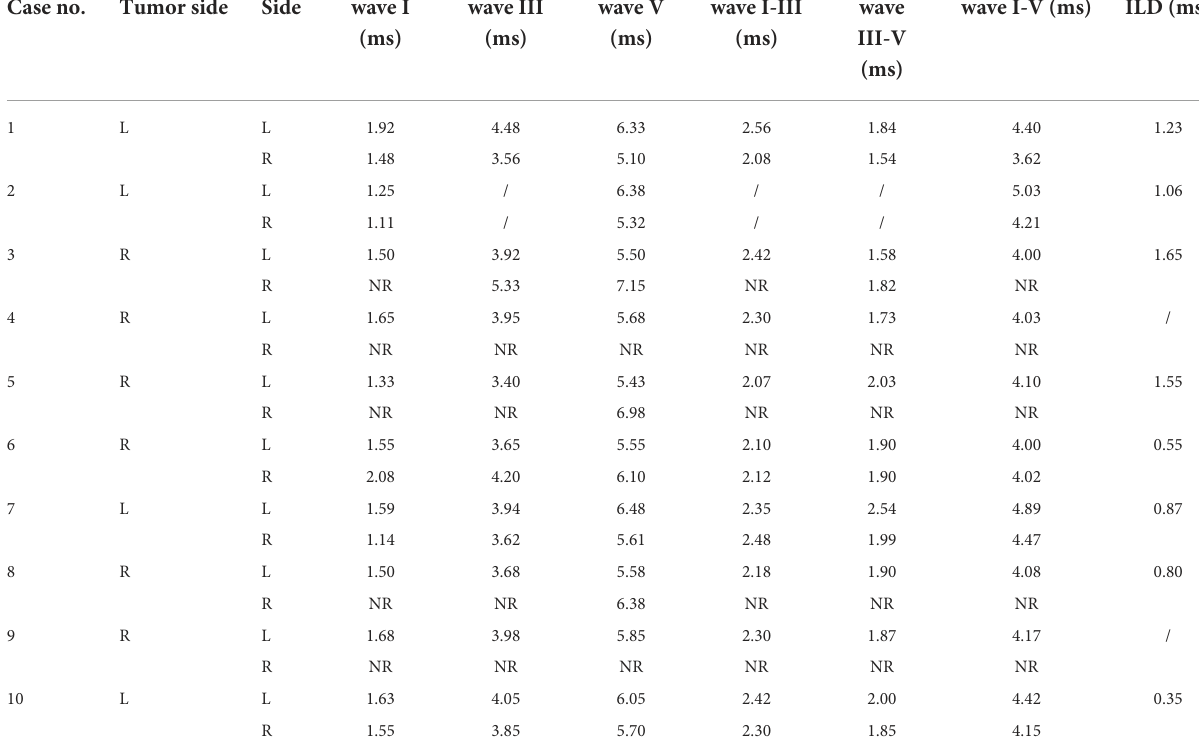
TABLE 2 The latency of ABR waves of the 10 patients enrolled in our study. Case no.